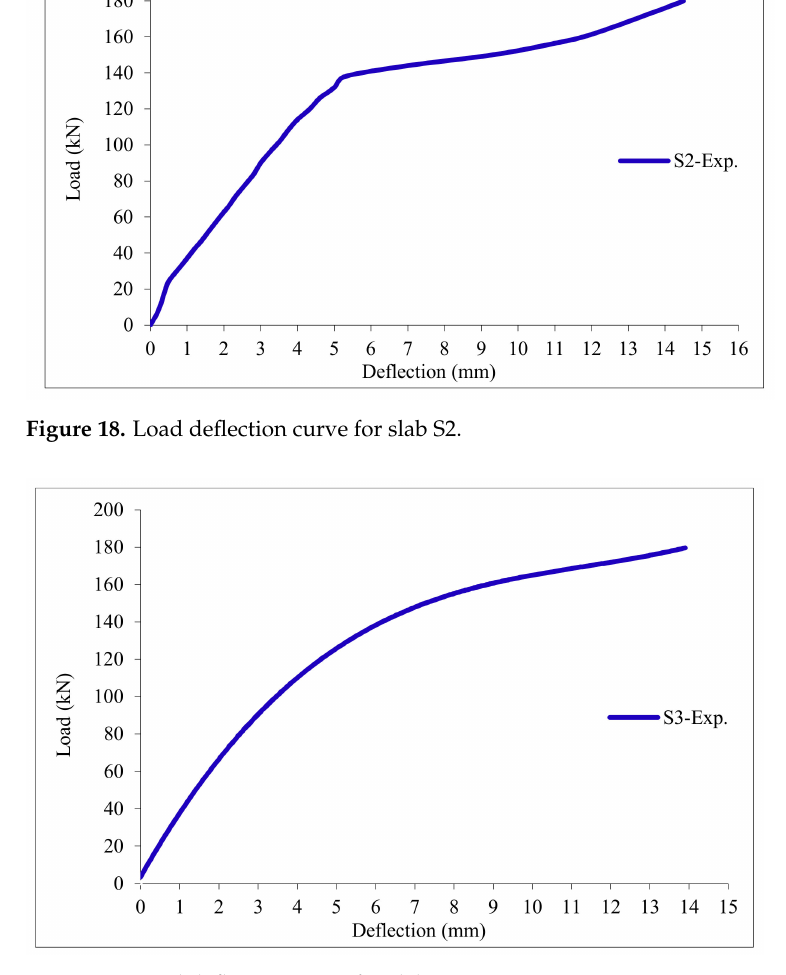
Figure 19. Load deflection curve for slab